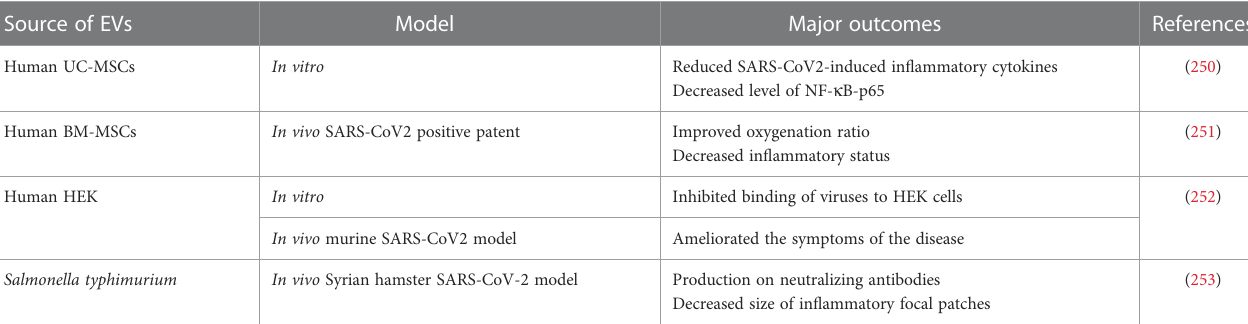
TABLE 9 Examples of EV use in preclinical studies related to the COVID-19 treatment. Source of EVs Model